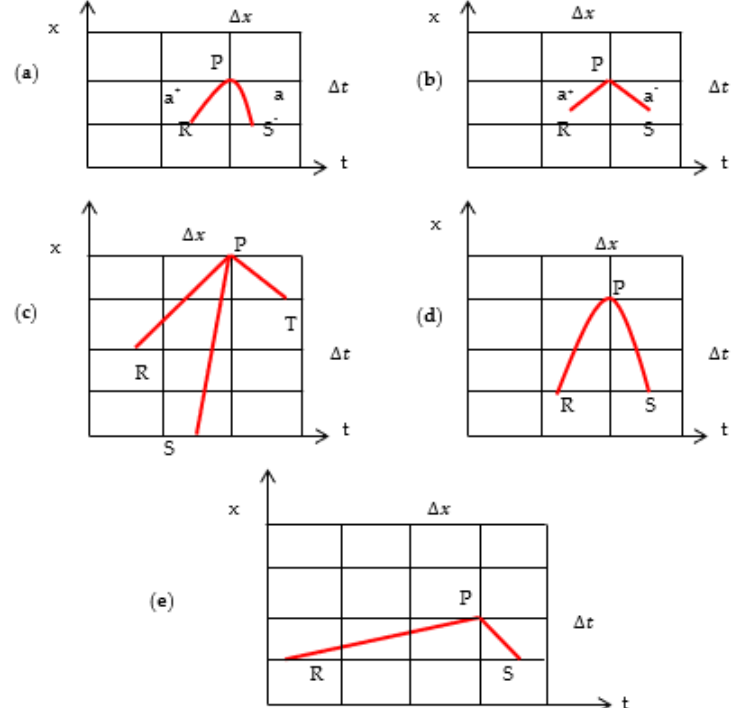
Figure 3. ( a ) Classical MOC grid system; ( b ) fixed linear grid system; ( c ) multimode MOC; ( d ) space reachback MOC; and ( e ) space reachout MOC.